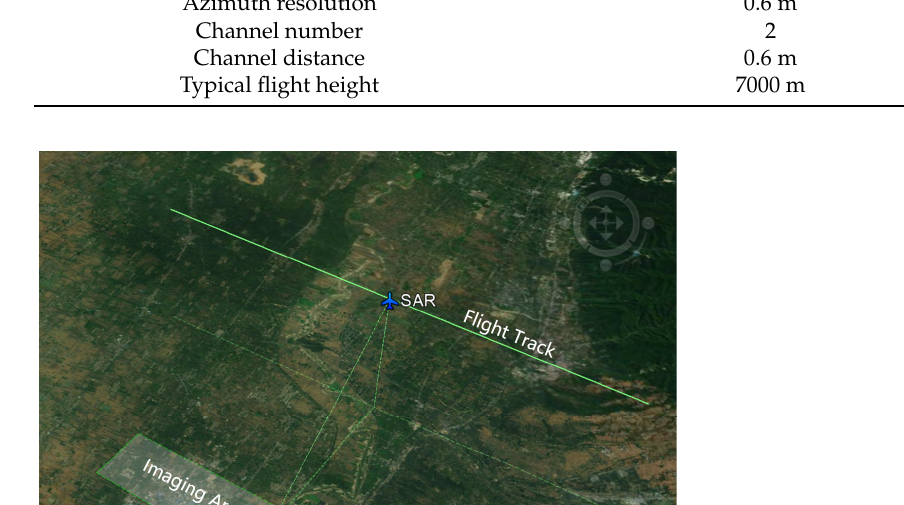
Figure 11. Geometric relationship of the SAR and the jammer.